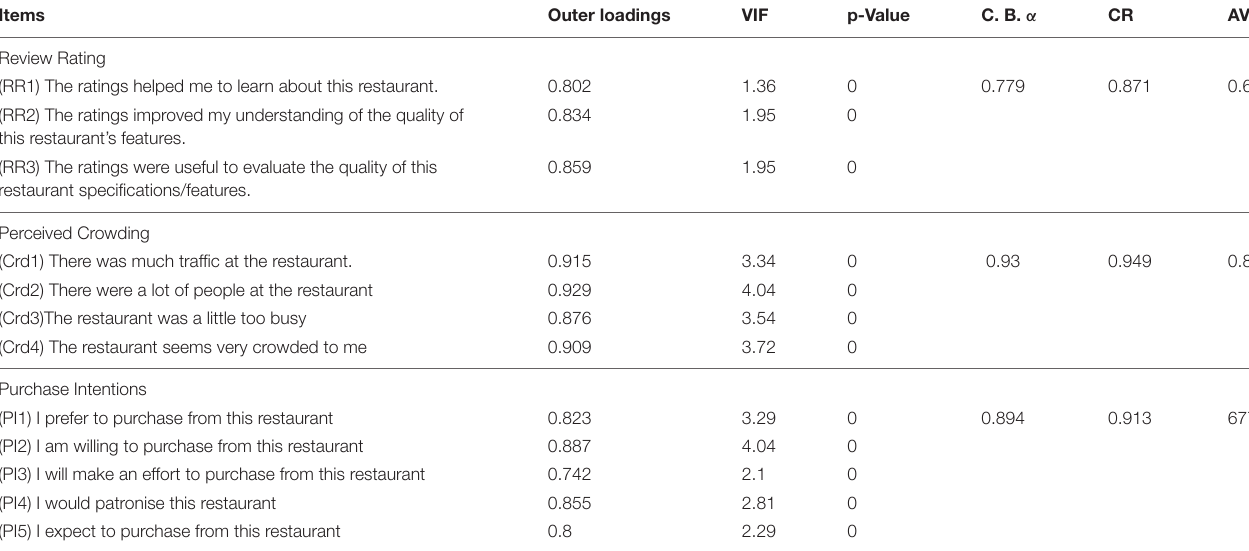
TABLE 2 | Reflective measurement model.